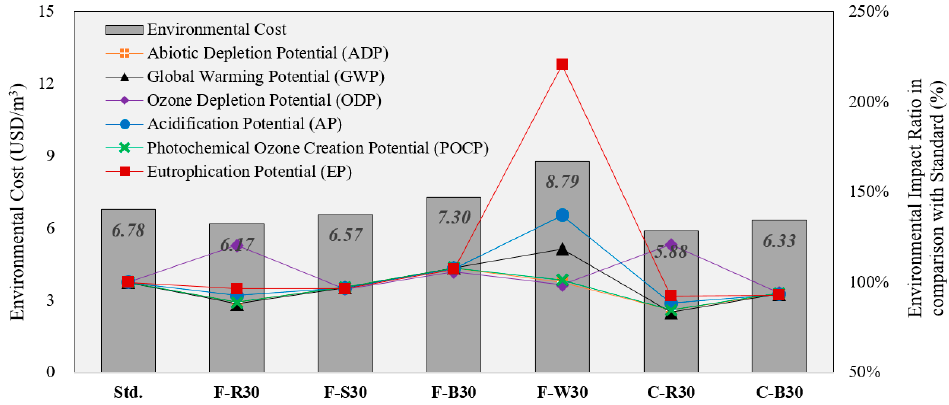
Figure 4. Environmental Cost and Environmental Impact Ratio in Comparison with Standard Mixture.